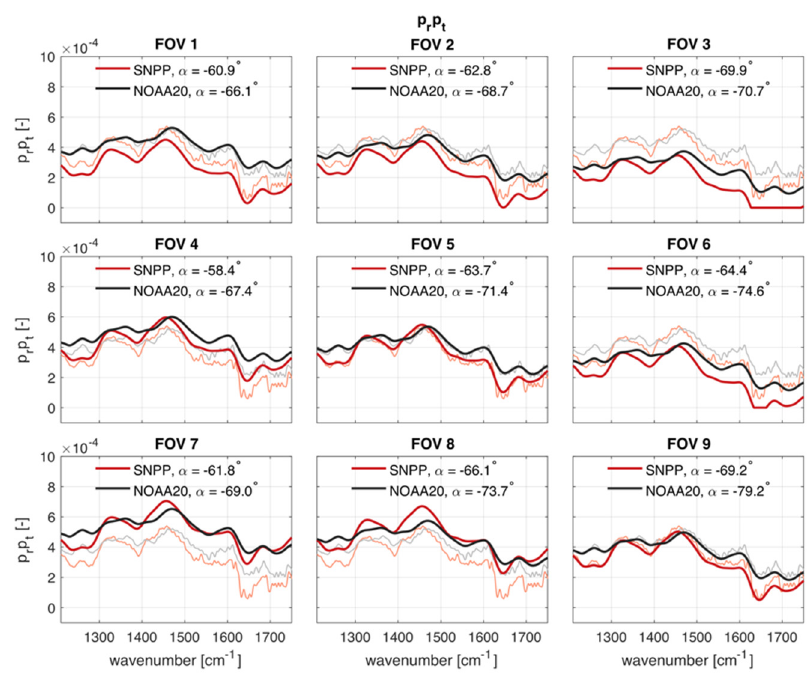
Figure 15. Combined scene select mirror and sensor polarization ( p r p t ) and sensor polarization angle derived from the midwave pitch maneuver data. SNPP is shown in red, and NOAA-20 is shown in black. The lighter weight lines are the derived p r p t values for the average over all fields of view, with no noise filtering or spectral averaging applied.